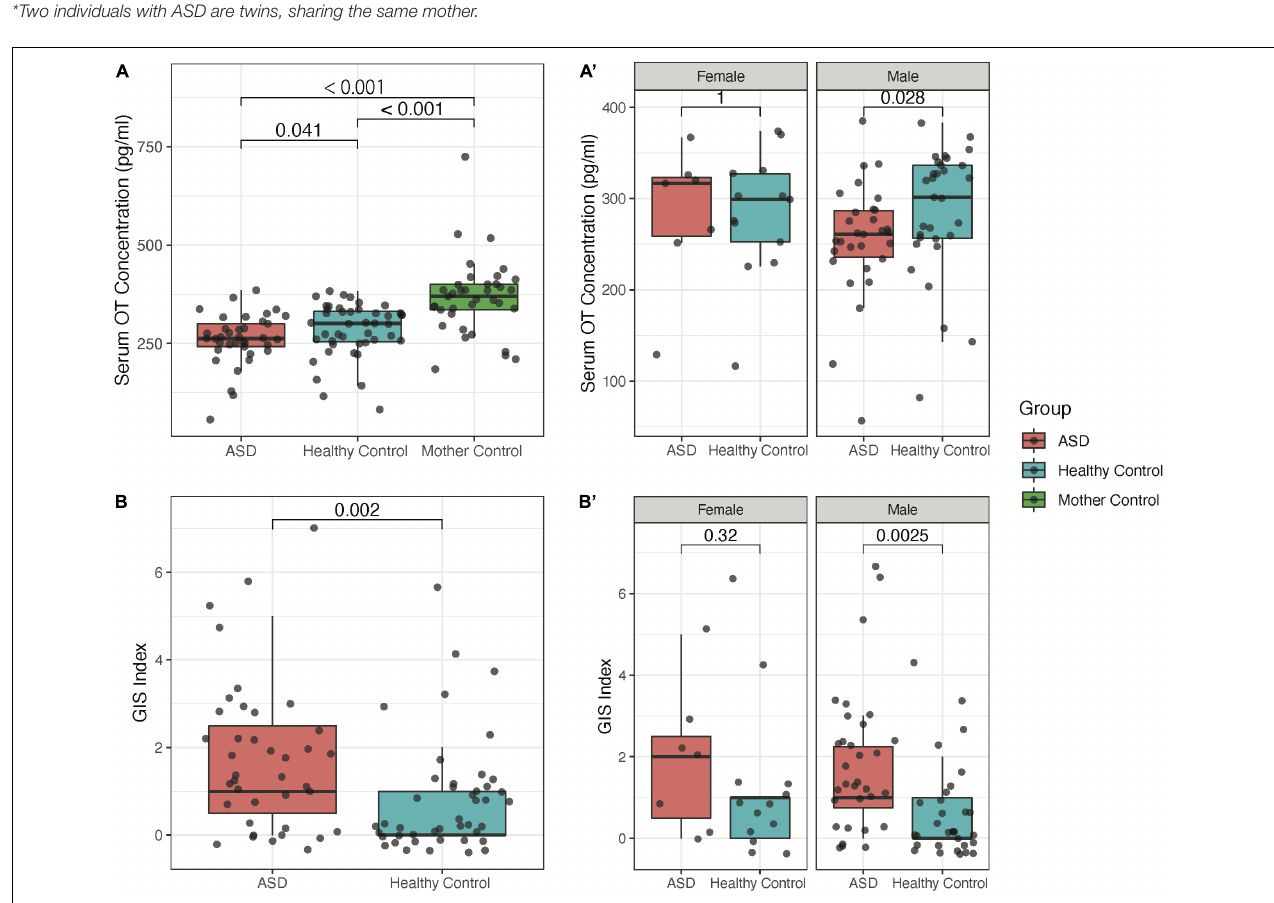
FIGURE 1 | Sex-dependence of serum OT concentration and GIS index between children with ASD, their mothers, and healthy controls. (A) Groupwise comparison of serum OT concentration in all subjects. (A (cid:48) ) Groupwise comparison of serum OT concentration by sex. (B) Groupwise comparison of GIS index between children with ASD and healthy controls. (B (cid:48) ) Groupwise comparison of GIS index by